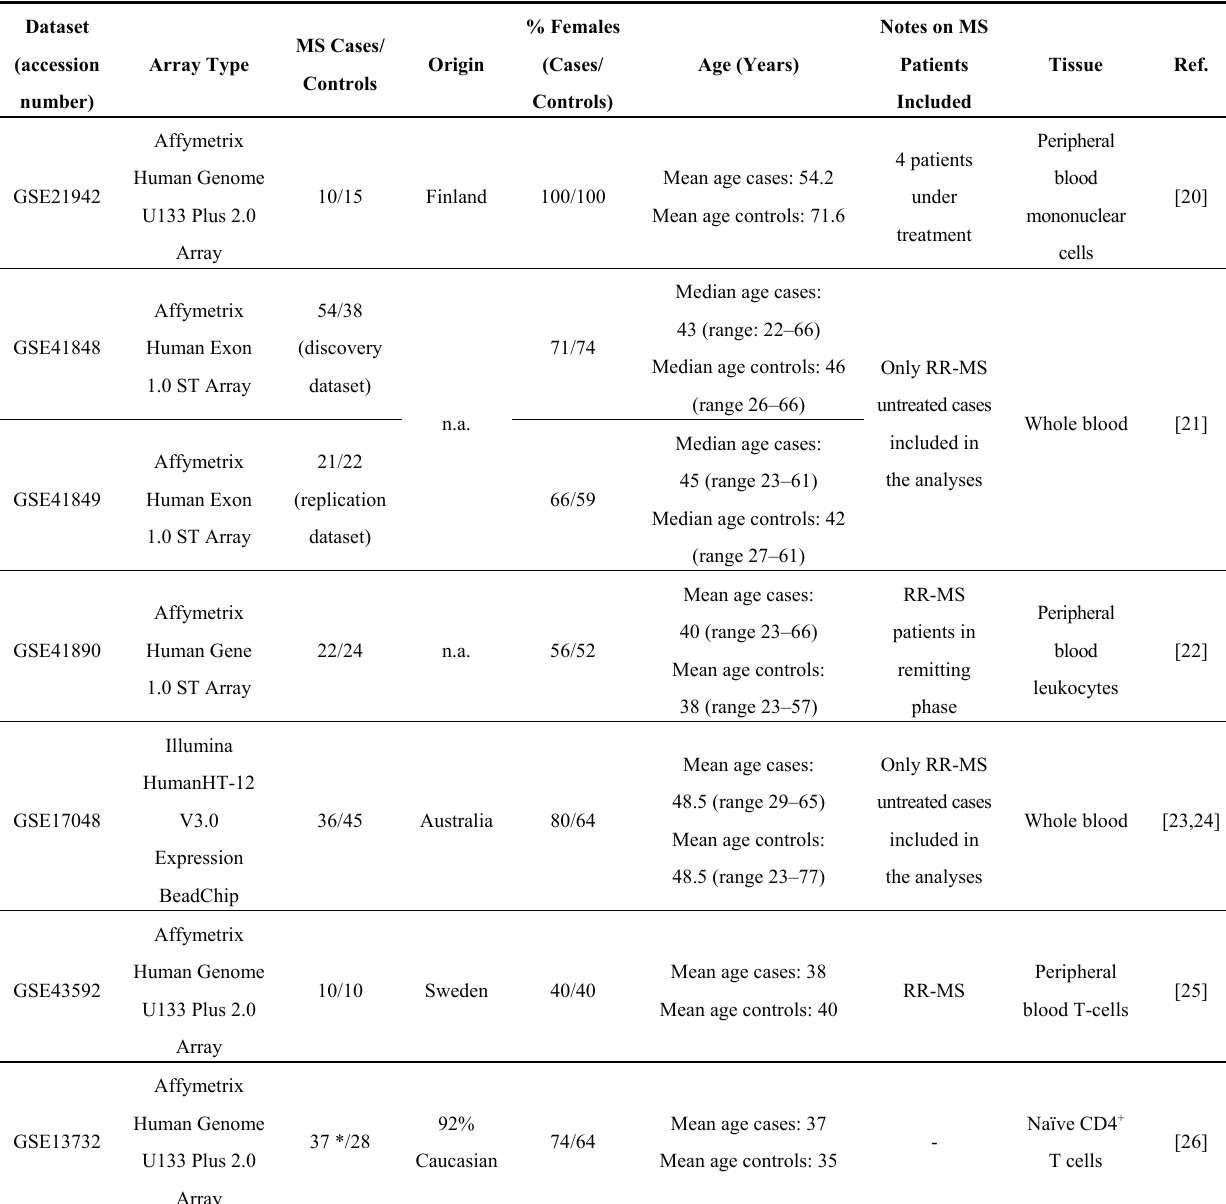
Table 1. Characteristics of multiple sclerosis (MS)-related datasets included in the